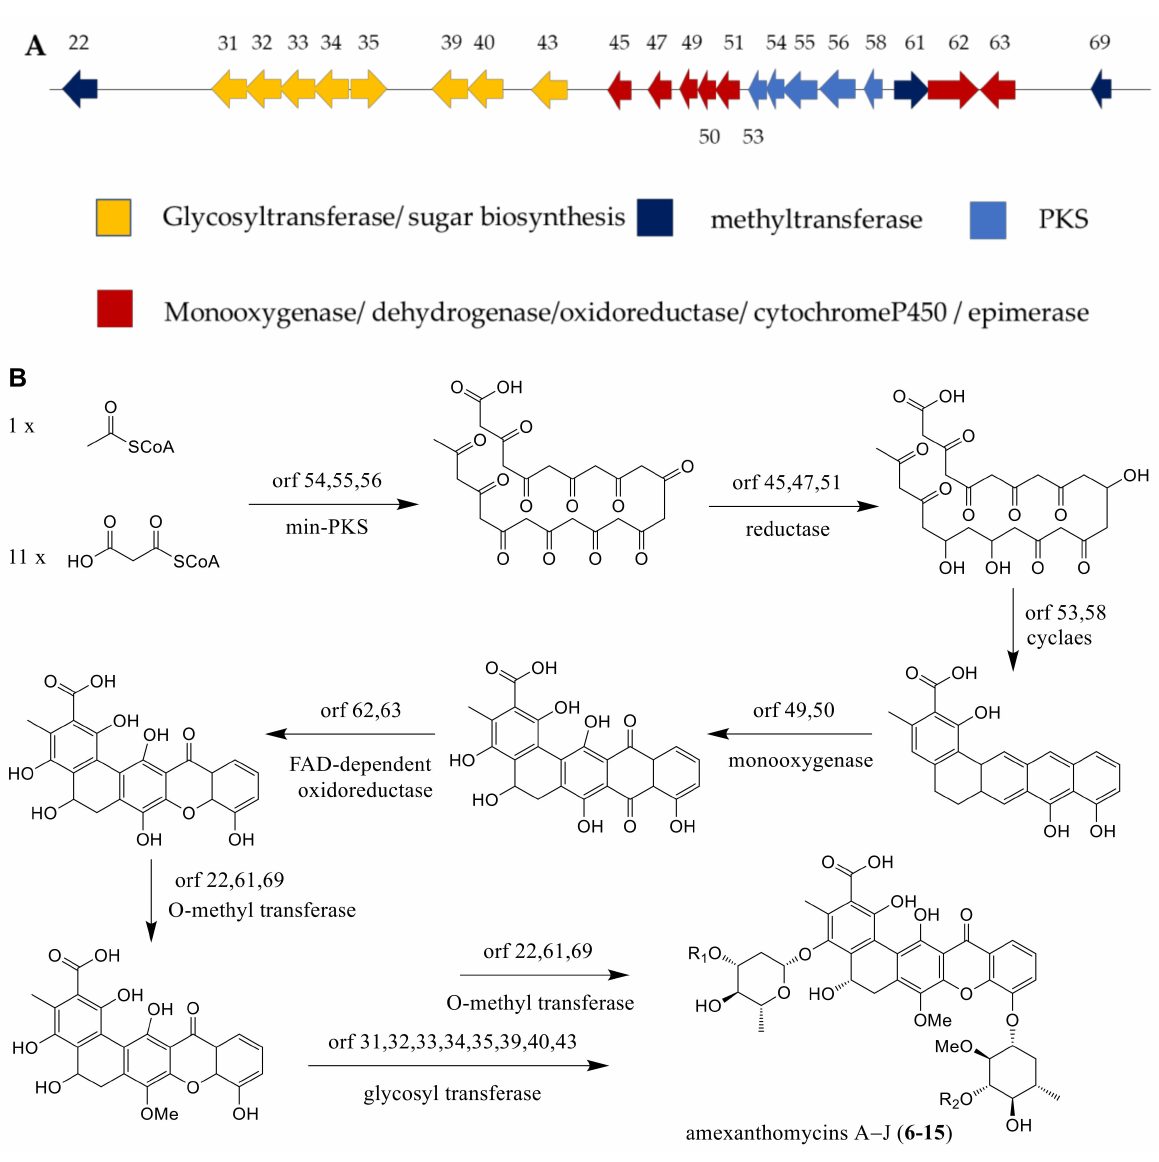
Figure 8. ( A ) The gene clusters of amexanthomycins A–J. ( B ) The biosynthetic pathway of amexanthomycins A–J [14]. The genome of A. orientalis ATCC 43,491 included a type I PKS which encoded by ORF 18-23 and synthesized the polyketide chain [24]. The monooxygenase and acyl- CoA ligase were encoded by ORF 7 and 25 which catalyzed arginine to 4-guanidino butyryl-CoA. D-glucose was catalyzed by oxidoreductase (ORF 13) and turned into D- glucuronic acid. Glycine and succinyl-CoA were transformed into 5-aminolevulinate by acyltransferase (ORF 16), and then turned into 5-aminolevulinate-CoA by acyl-CoA ligase (ORF 17). 5-aminolevulinate-CoA was transformed into